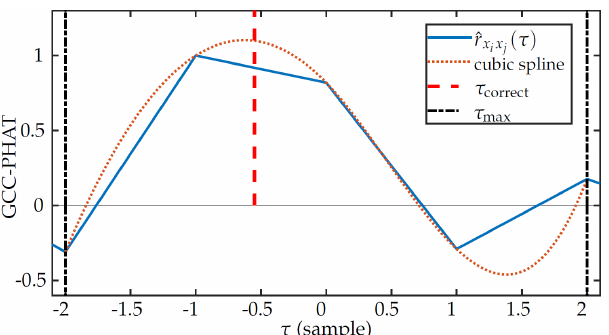
Figure 3. Effect of interpolation in generalized cross-correlation (GCC)-phase transform (PHAT): ( τ ) is the GCC-PHAT without interpolation. Note that ˆ r x i x j